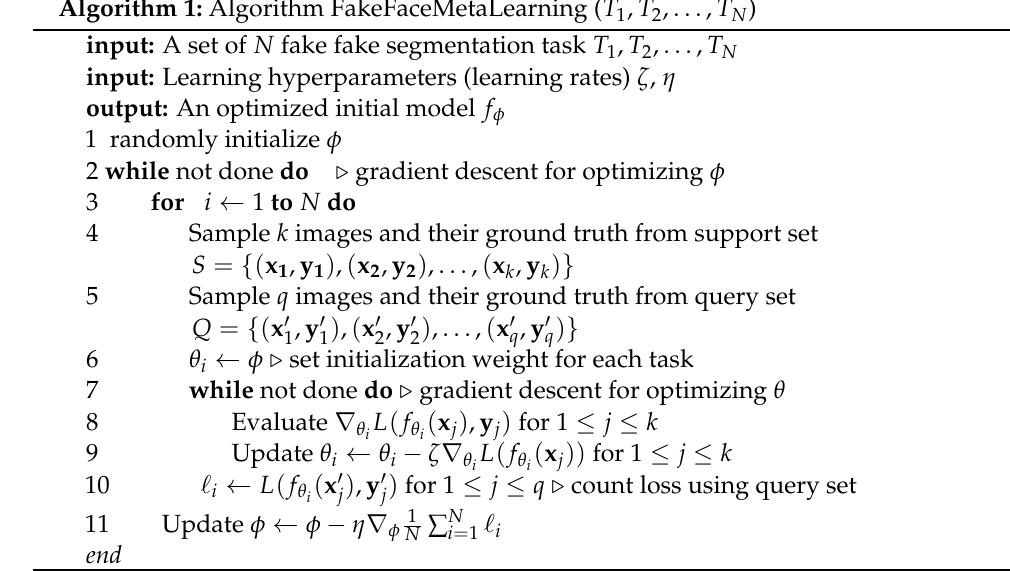
Algorithm 1: Algorithm FakeFaceMetaLearning ( T 1 , T 2 , . . . , T N